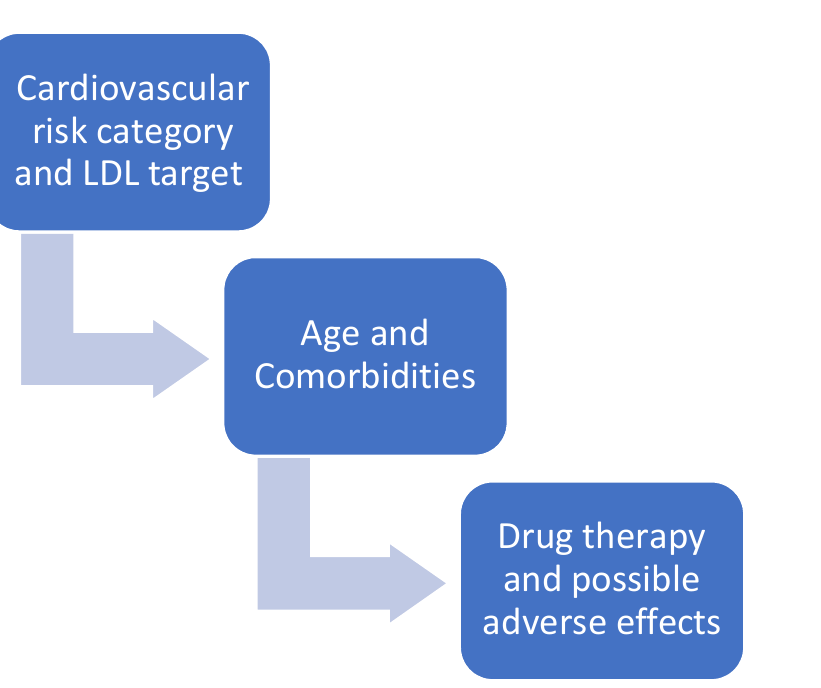
Figure 1. How to decide which statin and what dosage.